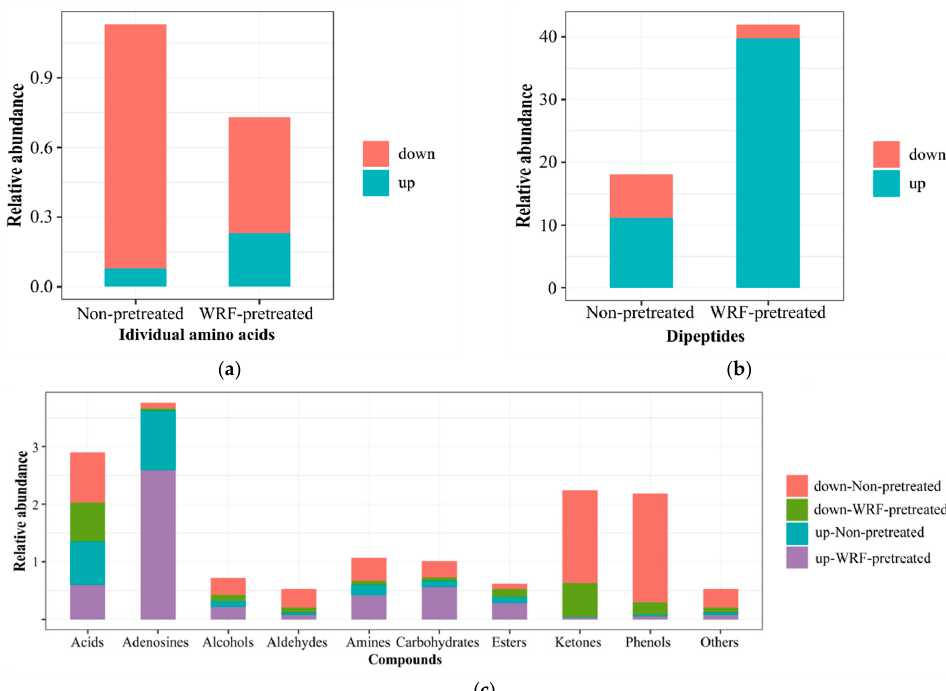
Figure 1. Up-or downregulated categories and relative abundance of metabolites between untreated (CON) and fungal-pretreated (WRF) corn straw. ( a ) Relative abundance of individual amino acids in CON and WRF corn straw; ( b ) relative abundance of dipeptides in CON and WRF corn straw; ( c ) Categories and the relative abundance of metabolites in CON and WRF corn straw. CON—untreated corn straw-based diet as control; WRF—replacing 40% untreated corn straw with 40% white-rot fungi-pretreated corn straw (DM basis); down—downregulated;